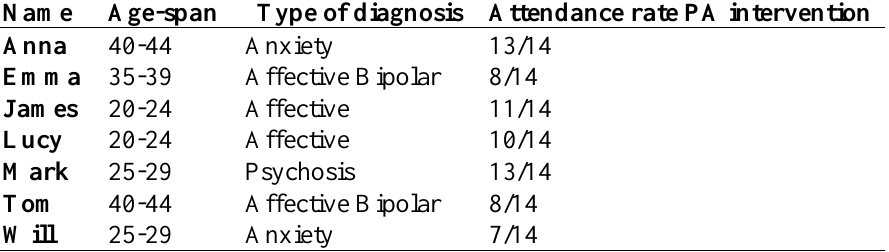
Table 1 . Demographics for participants and attendance rate in the PA